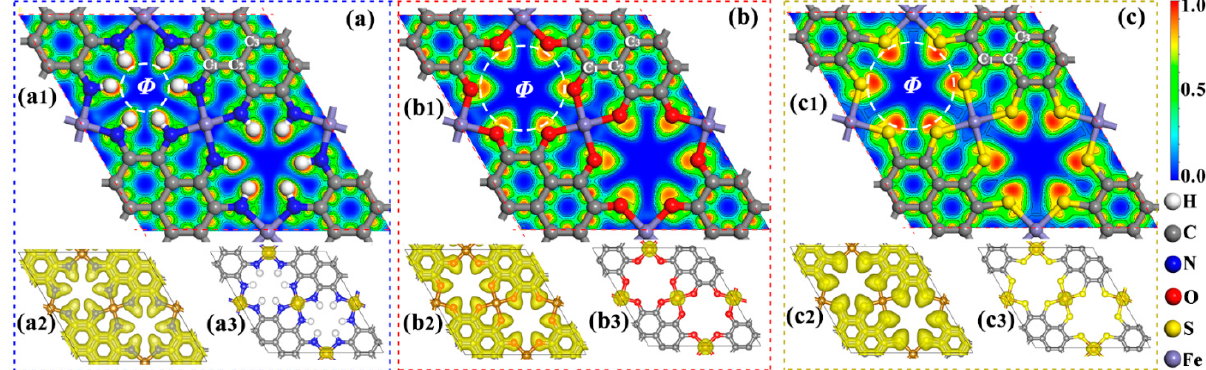
Figure 3. Geometries (1), electron localization function (ELF) (2), and spin density (3) of ( a ) Fe-NH- MOF, ( b ) Fe-O-MOF, and ( c ) Fe-S-MOF monolayers.